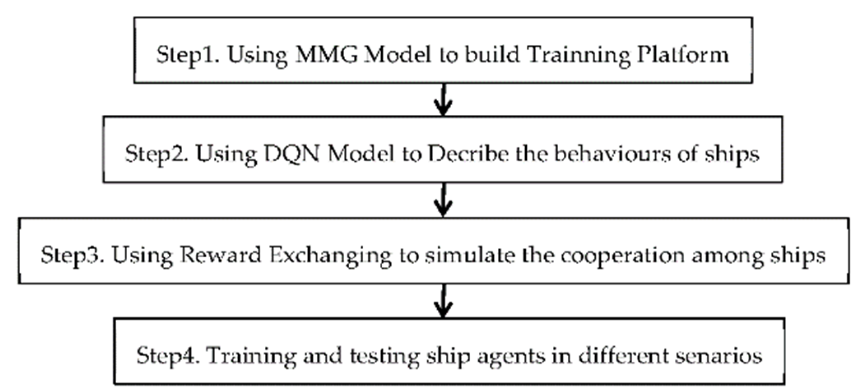
Figure 1. Flow chart.